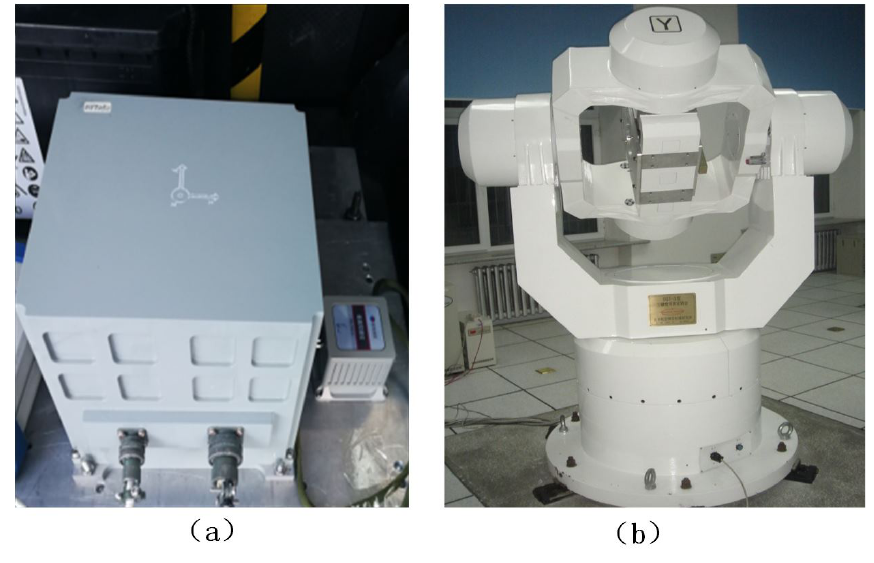
Figure 8. Experimental equipment. ( a ) Self-developed SINS. ( b ) Three-axis turntable.